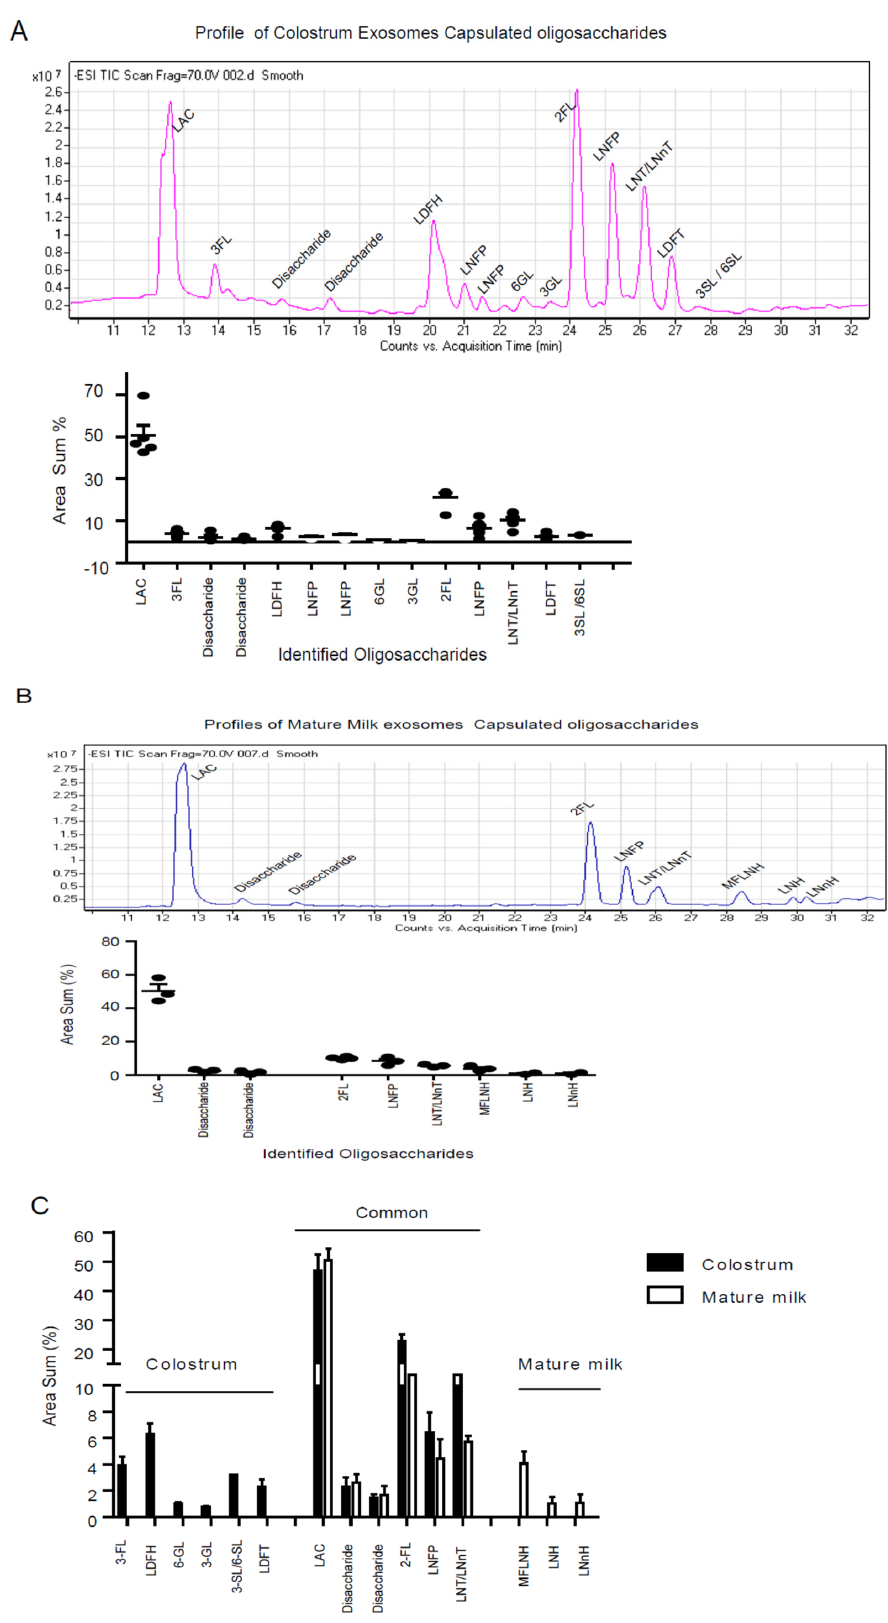
Figure 2. Characterization of human colostrum exosome oligosaccharide profile determined by LC-MS (high-performance liquid chromatography with tandem mass spectrometry). Representative exosome contained profile of HMOs from colostrum ( A ) and mature milk ( B ) were determined by LC- MS. Major peaks were identified by comparing retention times and mass spectra with authentic isolated standards. The variations in relative amounts (%) of the major individual oligosaccharides isolated from colostrum (n = 5) were determined. The comparison of exosomes encapsulated oligo- saccharide profile between colostrum and mature milk ( C ). Annotations for oligosaccharides abbre- viations: Lactose (LAC); 2-fucosyllactose (2 ′ -FL); 3-fucosyllactose (3-FL); Lacto-N-difucohexaose (LDFH); Lacto-N-fucopentaose I (LNFP I); Lacto-N-fucopentaose II (LNFP II); Lacto-N-Tetraose (LNT); Lacto-N-Fucopentasose (LNFP); Lacto-Difucotetraose (LDFT); 3-galactosyllactose (3-GL); 6- galactosyllactose (6-GL); 3-Sialyllactose (3-SL); 6-Sialyllactose (6-SL); Lacto-N-Fucopentaose I (LNFP I); Monofucosyl-lacto-N-hexaose (M FLNH); Lacto-N-Hexaose (LNH); Lacto-N-neohexaose (LNnH). 3.3. Colostrum Exosomes Capsulated Oligosaccharides Phagocytosis into Macrophages To explore how colostrum exosomes encapsulated oligosaccharides were transferred into recipient cells, colostrum exosomes were isolated and labeled with PKH26 (red), and the macrophages were live stained with CM-Dil (plasma, green) to track the dynamic pro- cess of exosomes phagocytosis into cells. The labeled colostrum exosomes were rapidly endocytosed into macrophages (15.55 ± 1.84 PKH26 spot/cell, n = 88, **, p < 0.001), and mainly distributed into cytosol and well co-localized with plasma area (ratio of exo- somes/cell plasma, 28.83 ± 3.59 %, n = 88, **, p < 0.001) (Figure 3A,B), and stable over 48 h,